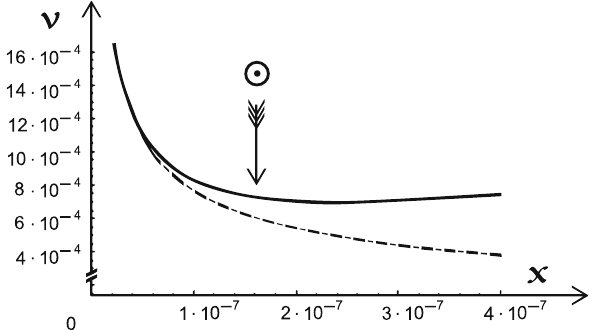
Fig. 2 Coated and uncoated rotation curves for a pointlike analogue Milky Way